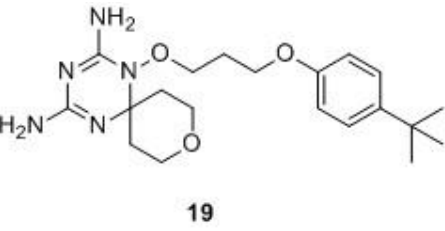
Figure 9. Chemical structure of triazines hDHFR inhibitors.